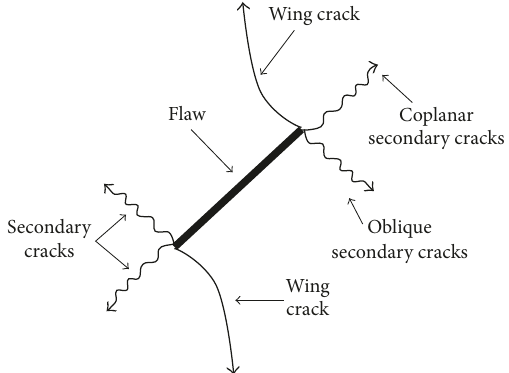
Figure 1: Crack types observed in precracked samples of rock under compression